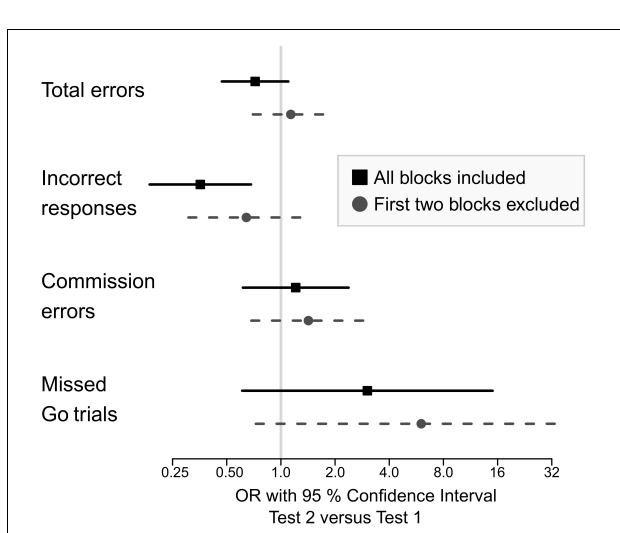
FIGURE 3 | Odd’s ratio with 95% confidence interval for making an error when all the blocks were included and when the two first blocks were excluded. When all blocks were included, there was a significant difference in the probability for responding incorrectly. When the first two blocks were removed, the difference